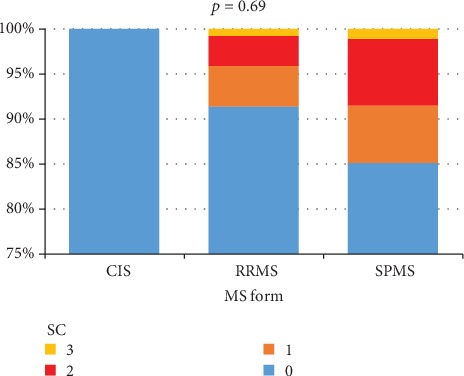
The relationship between SC and MS form.